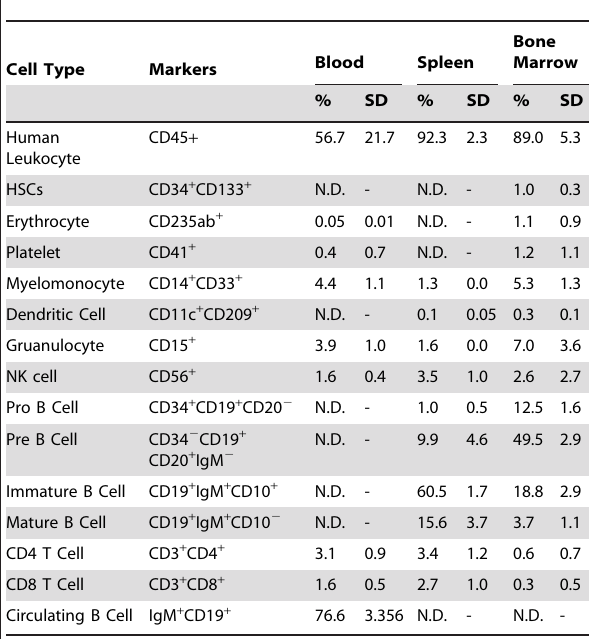
Table 2. Summary of reconstitution of adult NSG mice injected with 2.5–5 6 10 5 expanded CD34 + CD133 +